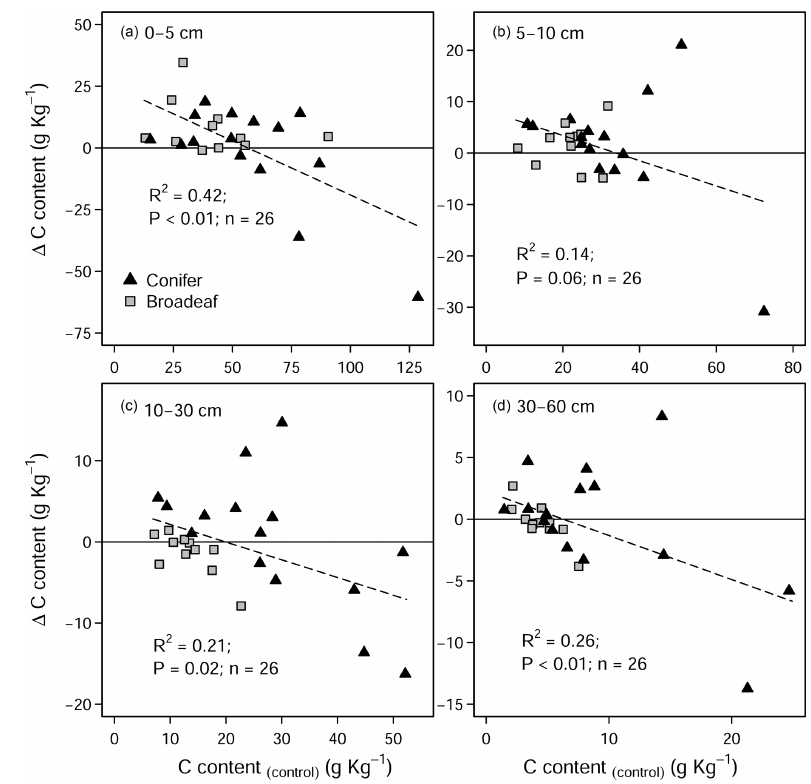
Figure A5. Scatter plot diagrams showing SOC contents in the control plots in relation to the liming-induced changes in SOC contents for the different sampling depths in the soil